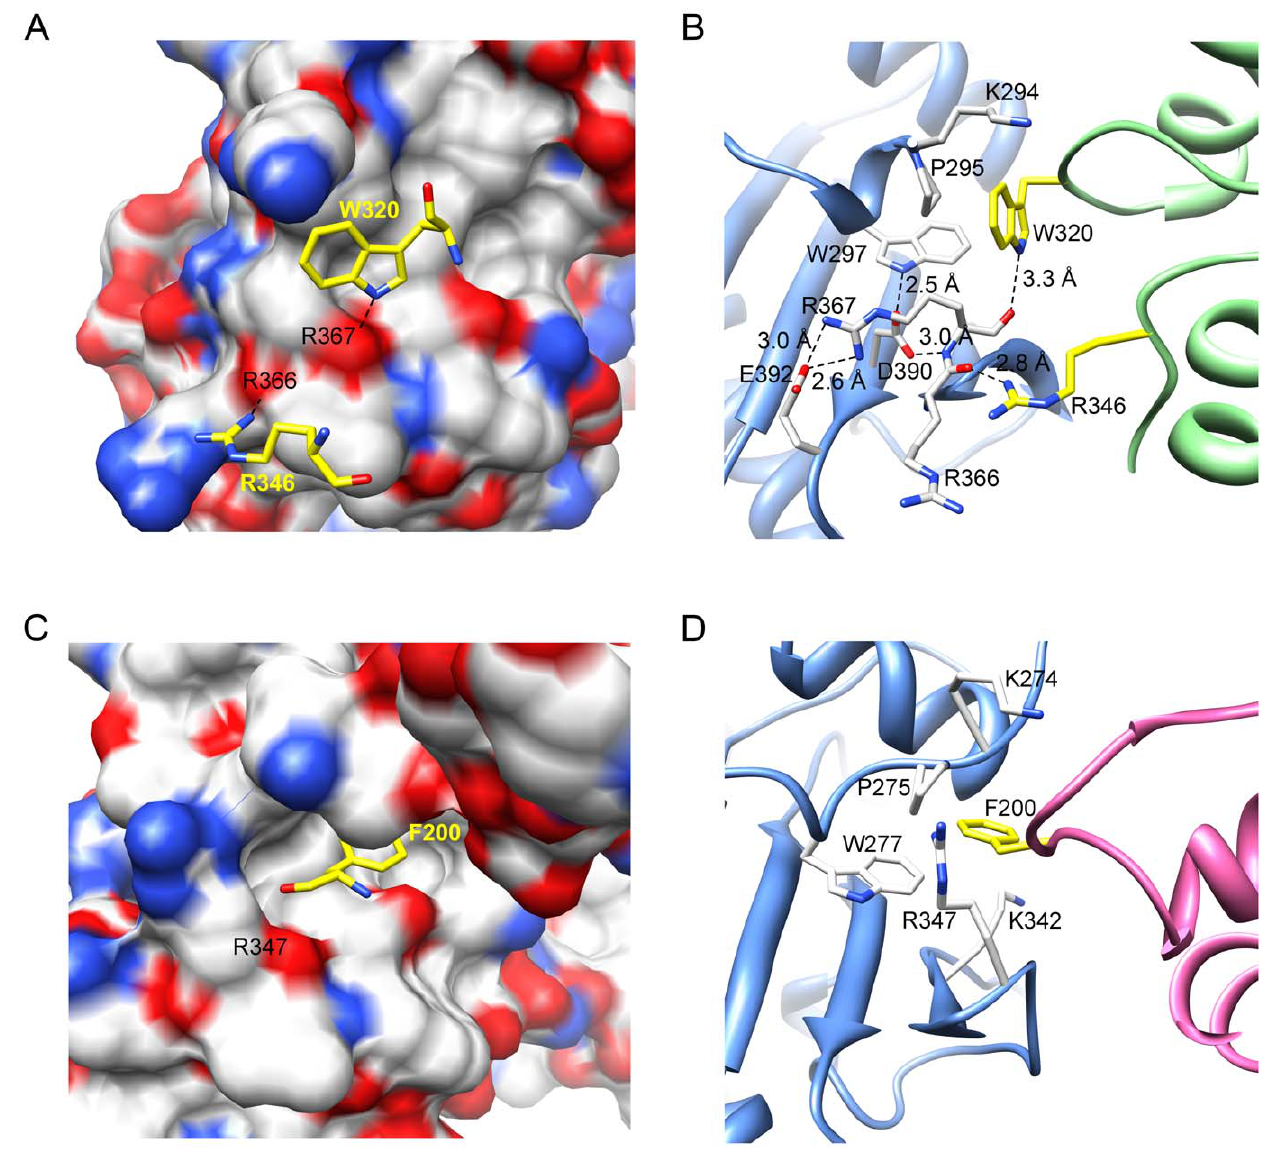
Figure 5. Protomer interactions in the M domain. (A) A protomer is shown as an electrostatic surface that contains a concave cavity for residues W320 and R346 packing with the neighboring protomer. (B) The major contacts of M domain between protomers, colored in blue and green, are shown with stick models. (C) The corresponding region of M domain in the full-length yeast HSP82 (PDB 2CG9) is shown as a surface. F200 from the N domain appears to take over the place of W320. (D) The contacting M and N domains in yeast HSP82 are colored green and pink, and the corresponding interactions are depicted with stick models. T273, F292 and Y344 (not shown) form part of the hydrophobic pocket but are not involved in direct